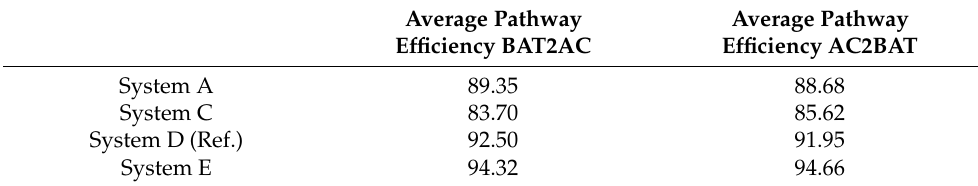
Table 2. Average pathway efficiencies of the battery